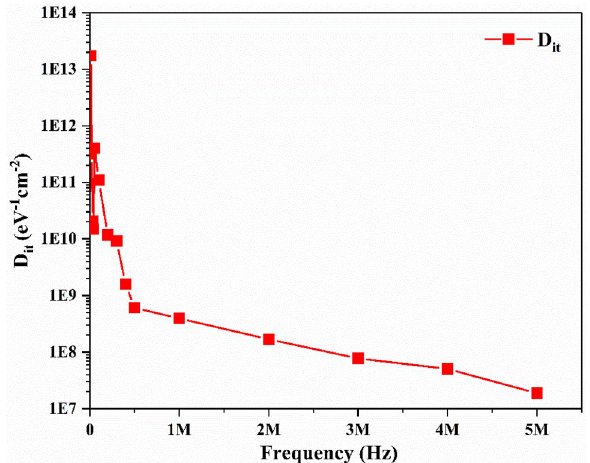
Figure 4. Frequency dependent D it plot for the Ag/TiO 2 -NW/Ge-NW/Si (MOS)